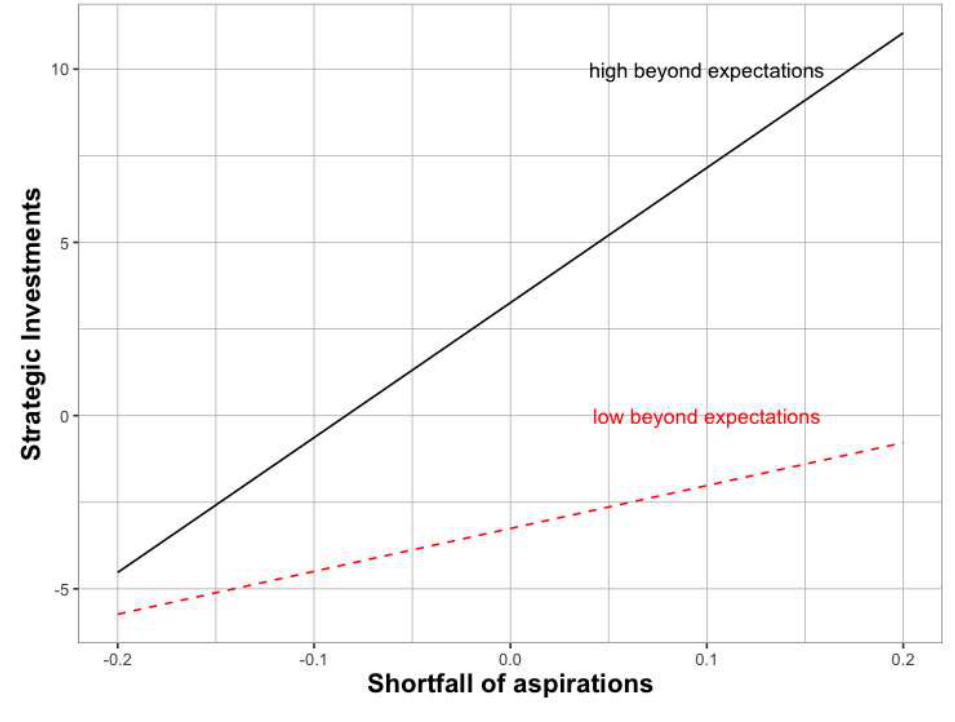
Figure 1. Moderating effect between shortfall of aspirations and beyond